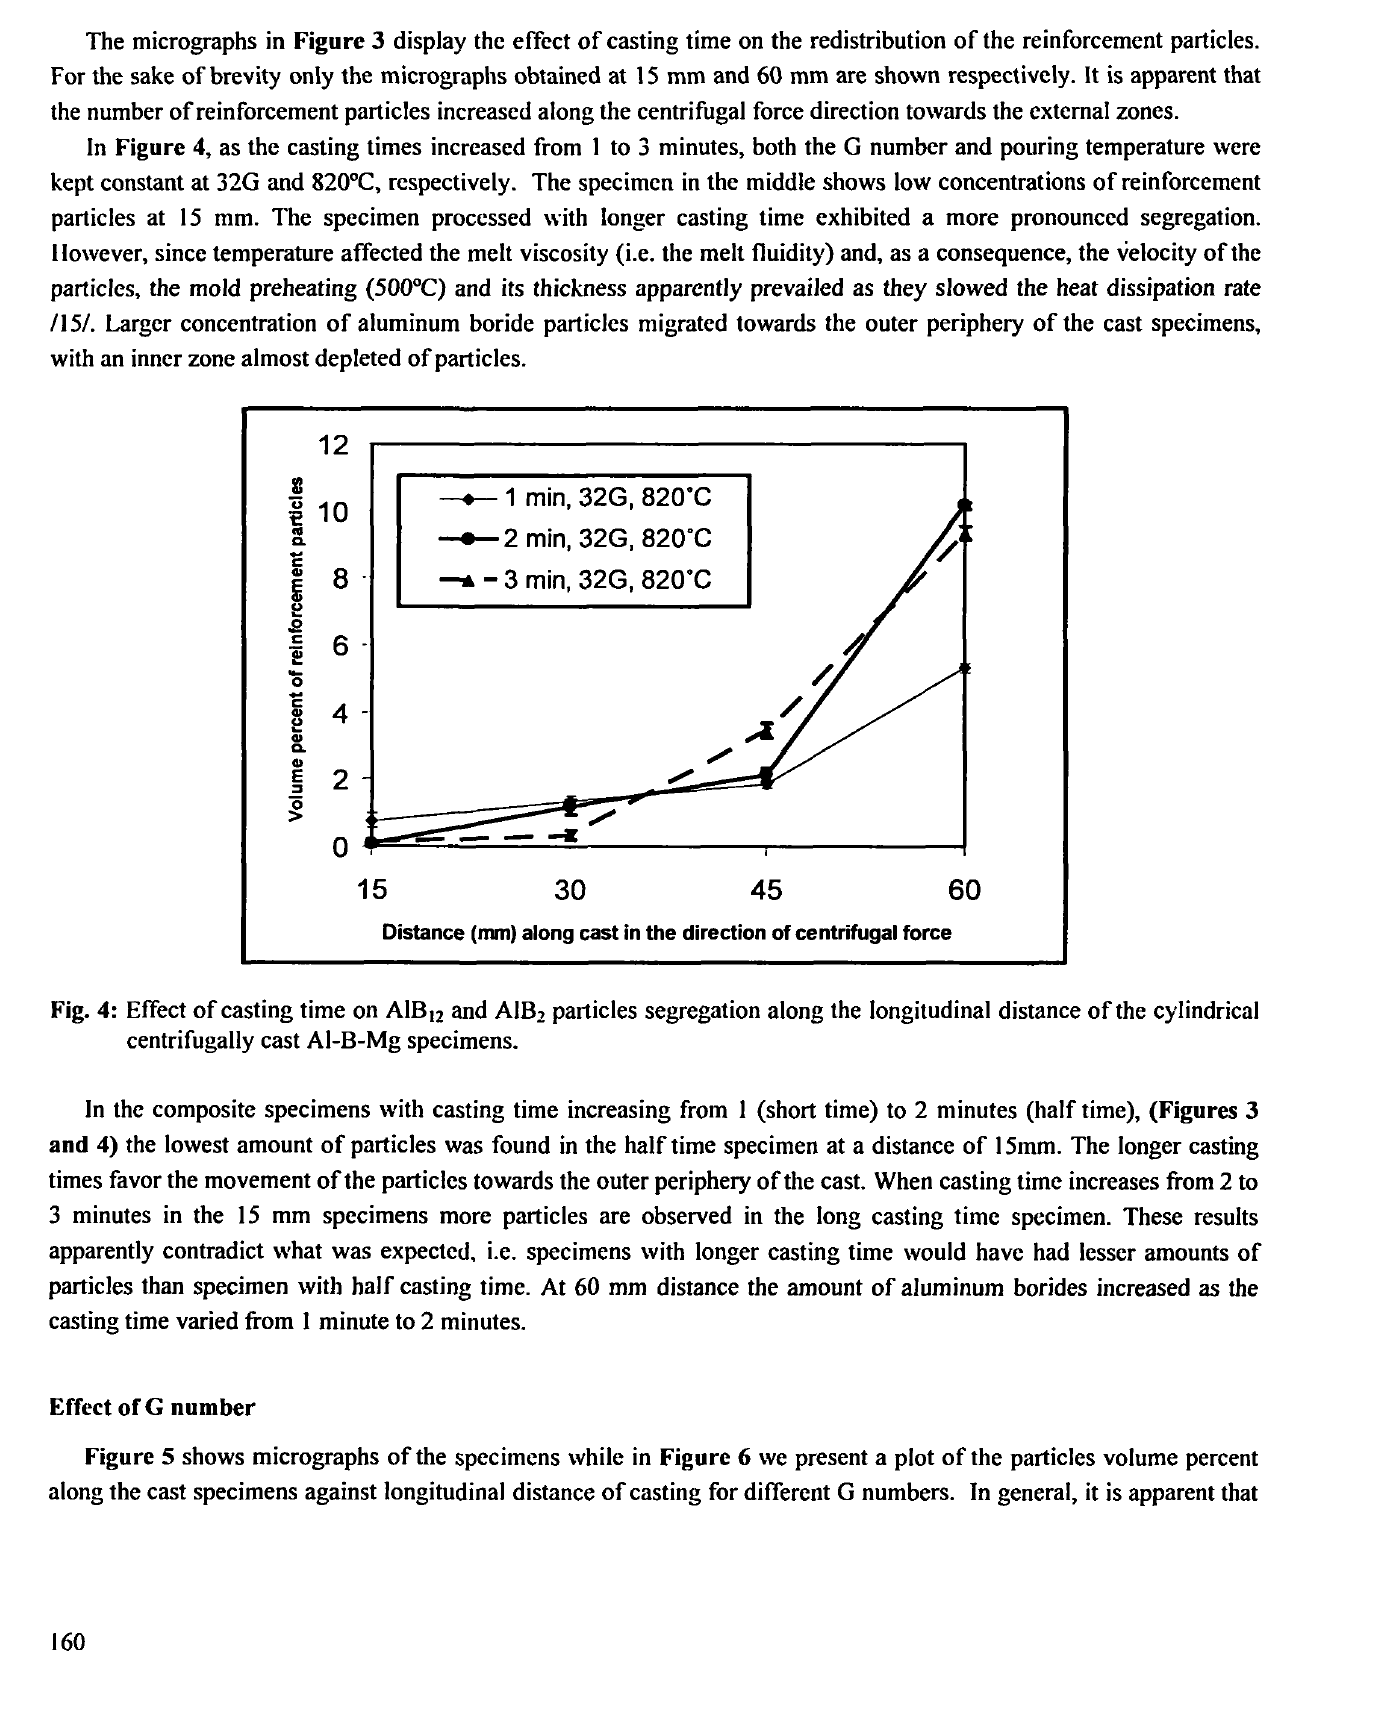
Fig. 4: Effect of casting time on A1B] centrifugally cast Al-B-Mg